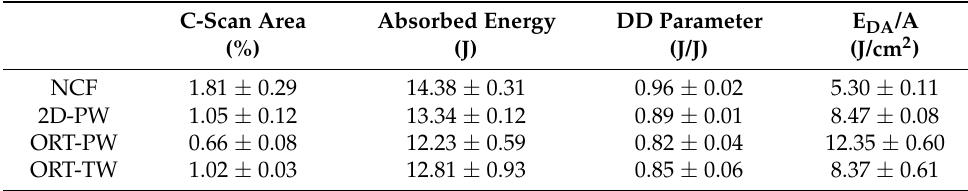
Table 1. Summary of the intensity of damage